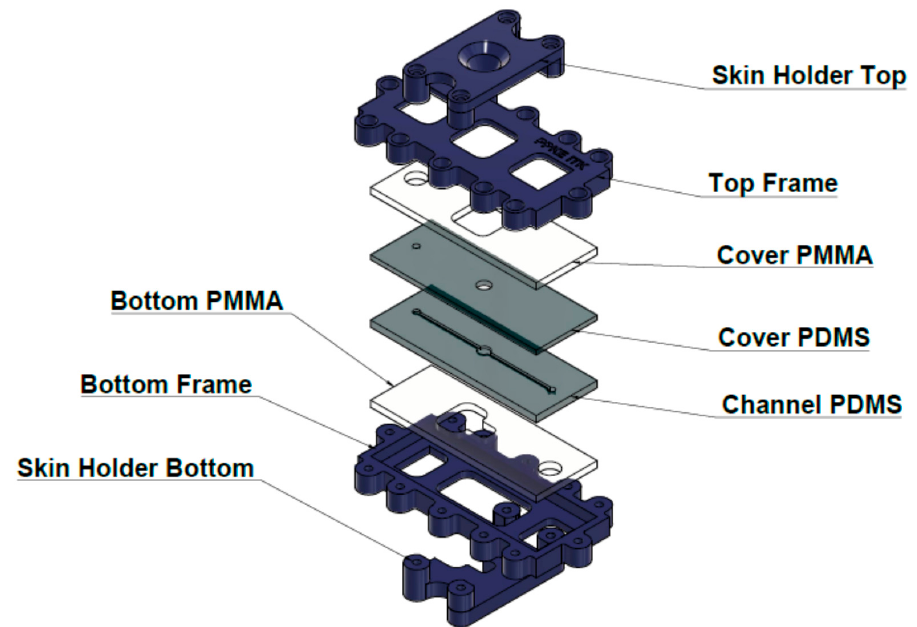
Figure 2. Structure of the “skin-on-a chip” microfuidic diffusion cell. PDMS: polydimethyl-siloxane; PMMA: polymethyl-metacrylate.